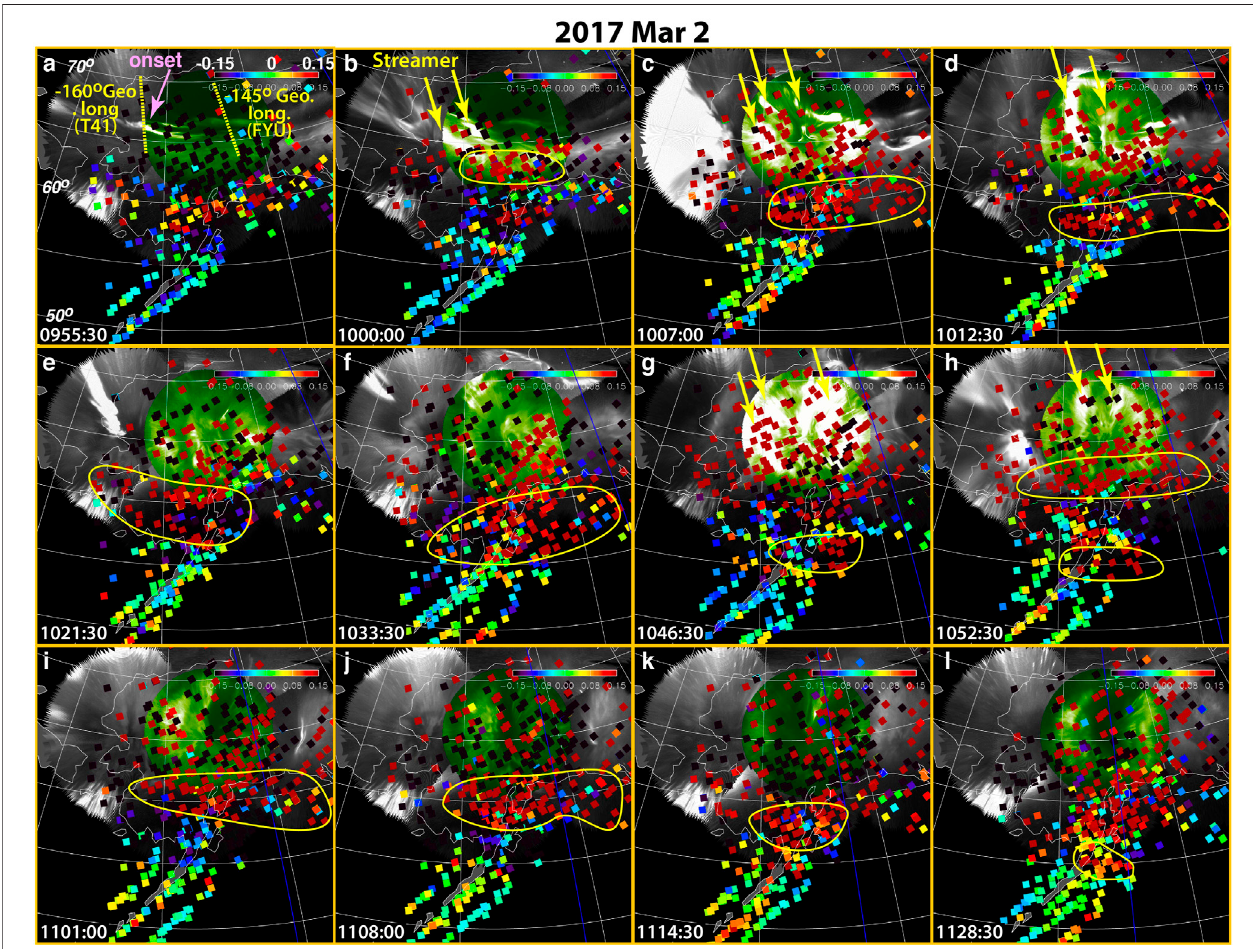
FIGURE 3 | Sequence of the auroral images during the period of interest on March 2, 2017 (557.7 nm emissions from the Poker Flat ASI with THEMIS ASI white light emissions in regions outside the Poker Flat ASI fi eld-of-view, FOV), overlaid with all available Δ TEC measurements over the Alaska sector. Yellow curves encircle equatorwardmovingregionsof Δ TECenhancementsequatorwardoftheauroraloval.Darkbluelineisthemagneticmidnightmeridianandlongitudelinesarespaced15 °